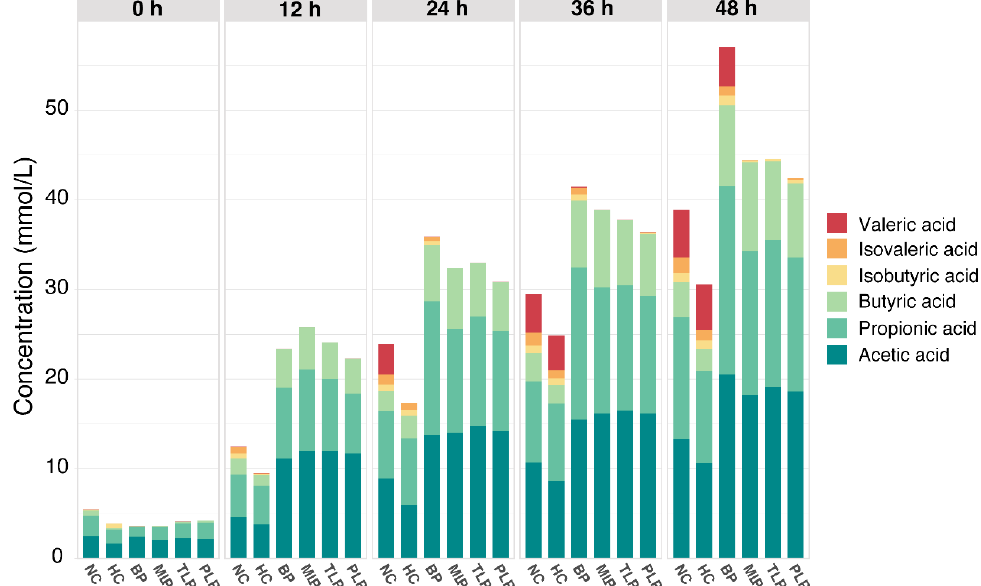
Figure 1. The levels of SCFAs in different groups and time during in vitro culture. NC: the feces of the healthy population were inoculated in FAM; HC: the feces of the hyperlipidemic people were inoculated in FAM; BP, MLP, TLP, PLP: the feces of the hyperlipidemic people were inoculated in FAMs with 0.5% of BP, MLP, TLP, and PLP. All experiments were repeated in triplicate (n = 3).